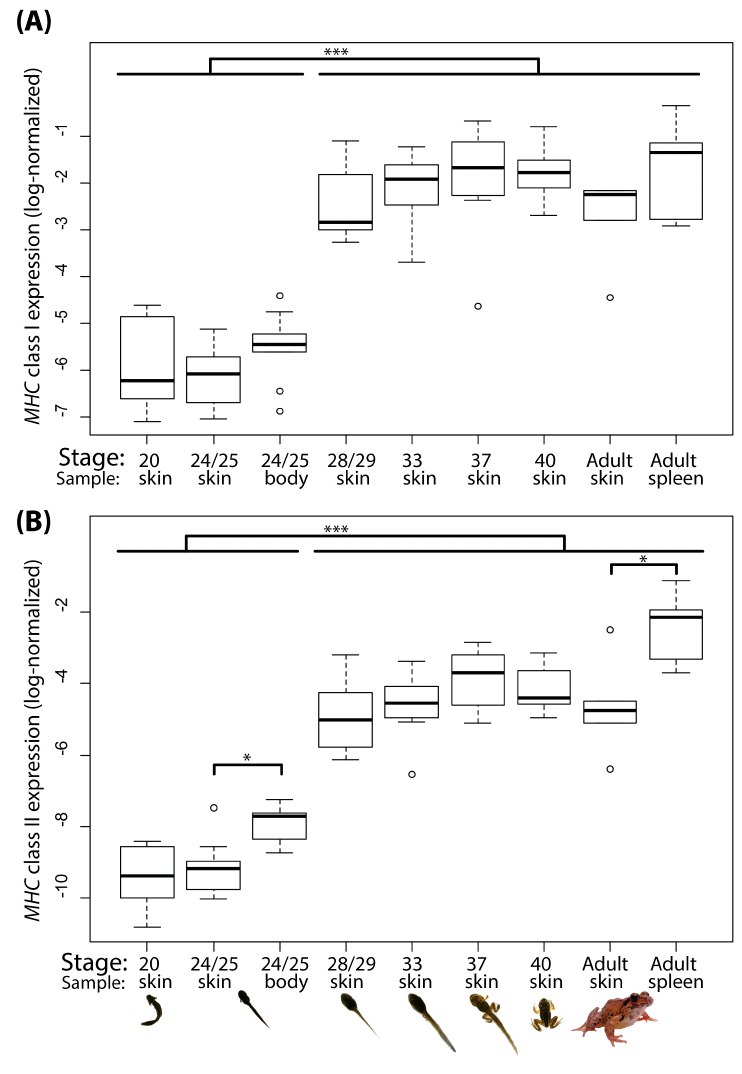
Figure 2. Boxplot of ( A ) MHC class I and ( B ) MHC class II expression in mRNA of Rana ornativentris tadpole skin during six ontological stages and other samples: stage 24 / 25 body, and adult skin and spleen. MHC expression values from qPCR were normalized by the GAPDH control gene and log-transformed for normality (log-normalized). * p < 0.05, *** p < 0.0001.